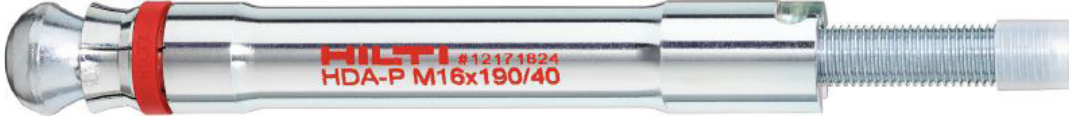
Figure 1: Pre-set undercut Hilti HDA-P anchor.